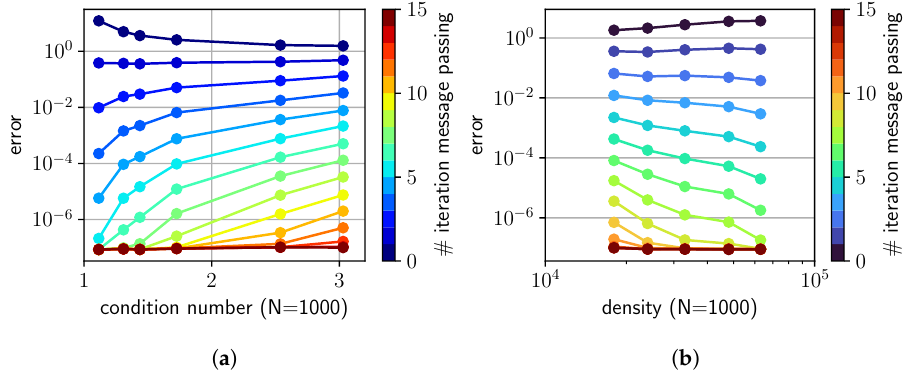
Figure 15. The plots show the error after a certain number of Message Passing iterations for the LESs analyzed in Figure 14, but only for LESs with N = 1000. In ( a ), the errors are shown for the set of LESs with constant density. In ( b ), the errors are shown for LESs with constant condition